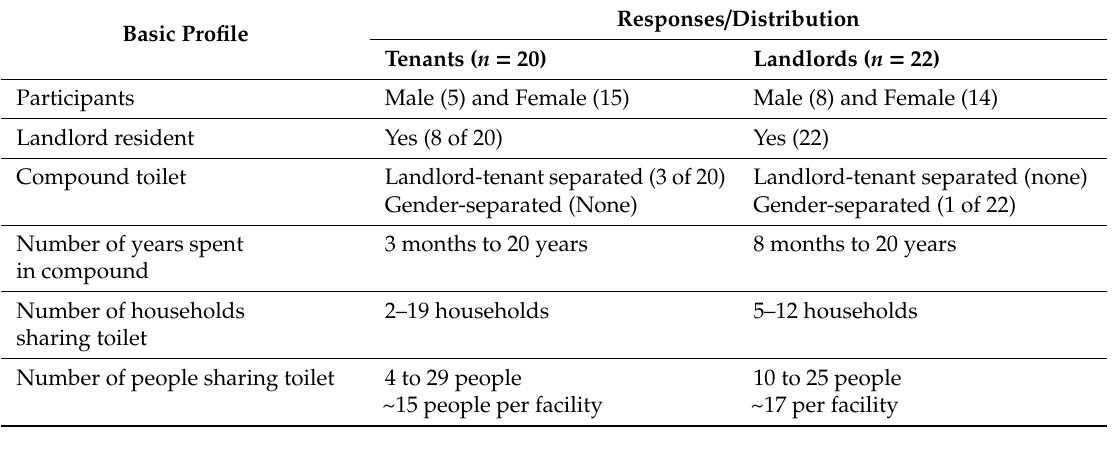
Table 1. Basic profile of participants from the in-depth interviews (IDIs).